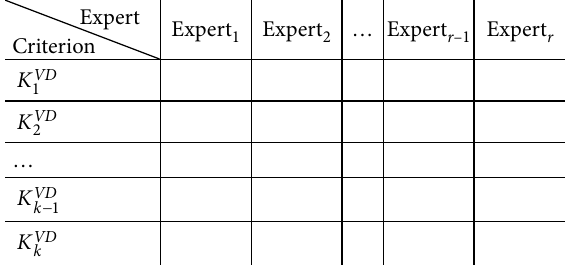
Table 1. Matrix of weights assigned to each criterion by r th experts Expert